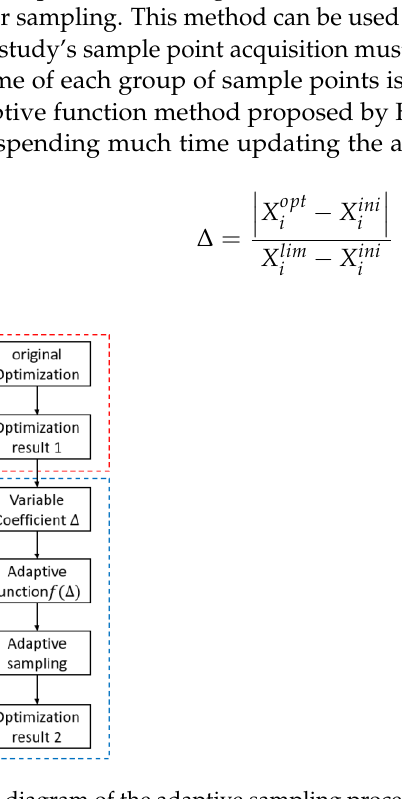
(10) Figure 6. Sampling point distribution of design variables.